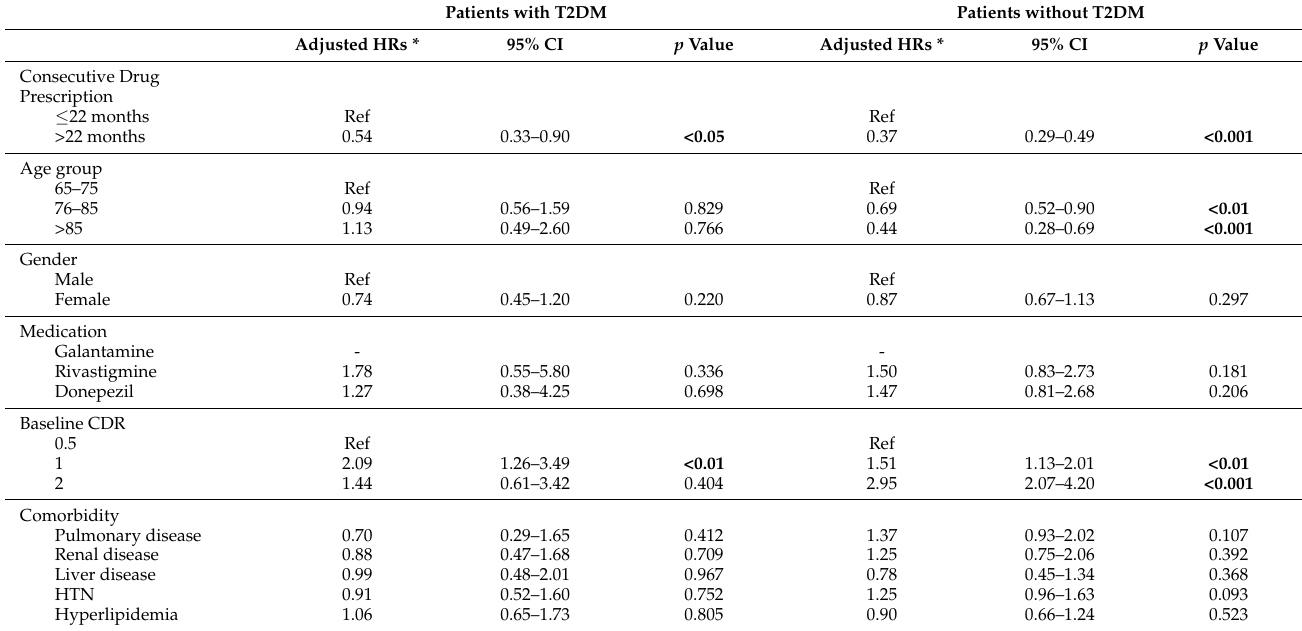
Table 4. Cox proportional hazards model for rapid decline within 2 years in patients with Alzheimer’s dementia with and without type 2 diabetes mellitus (DM).